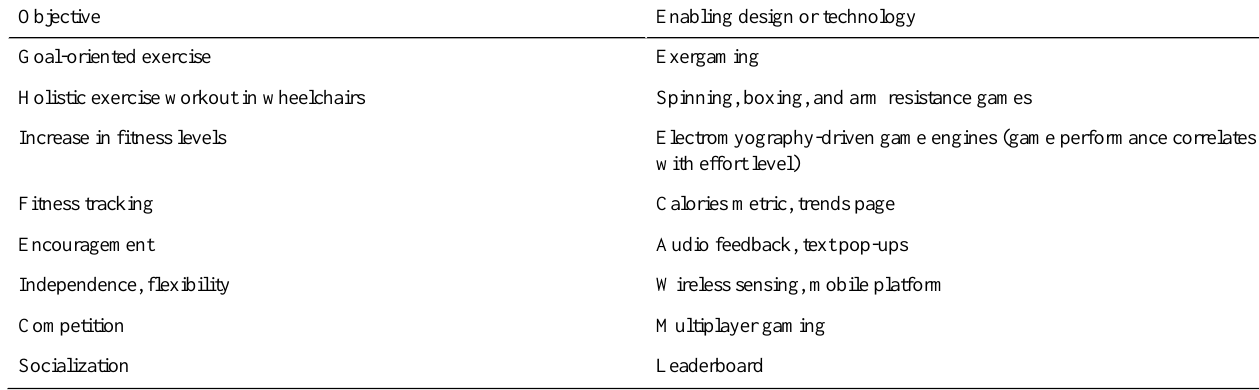
Table 1. Features implemented in the Workout on Wheels-Mobile app and the corresponding enabling design.